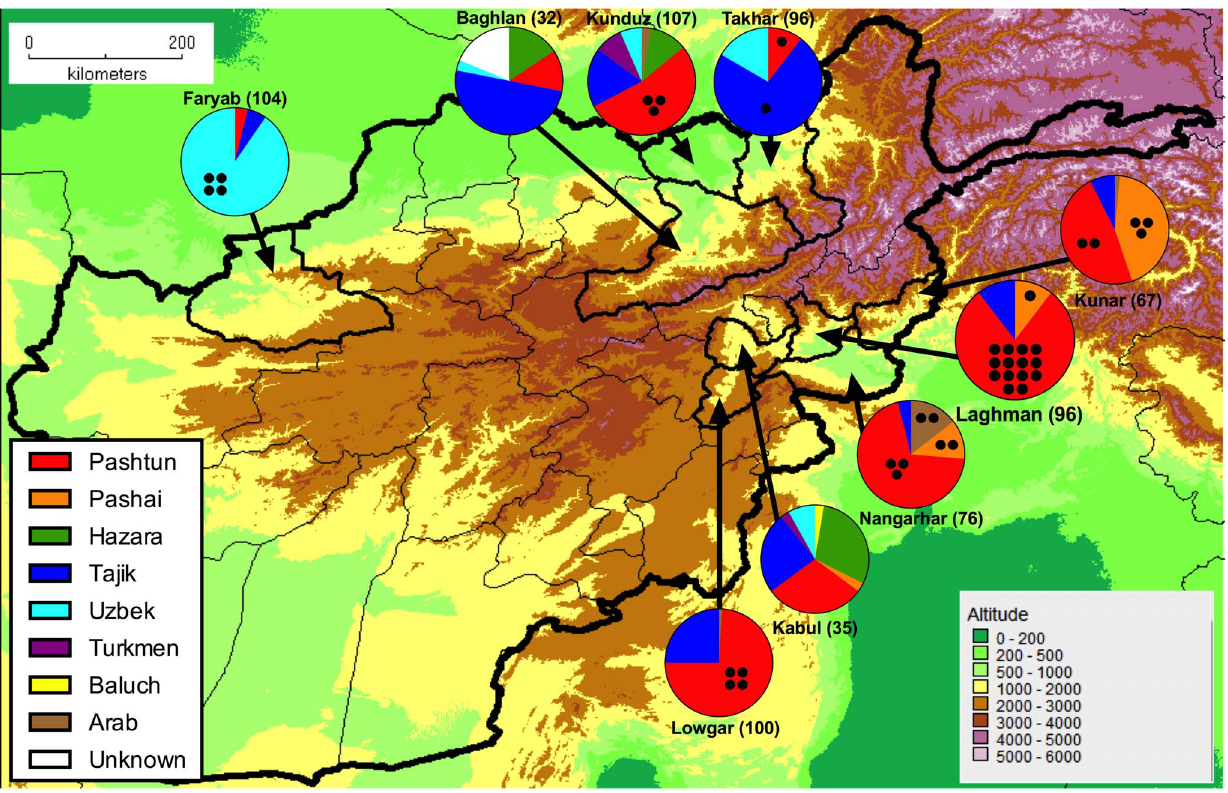
Figure 1. Location, ethnicity and number of Mediterranean variants for the individuals studied. Black circles placed within the relevant segment represent individuals of a particular ethnic group with the 563C . T Mediterranean mutation. The number of individuals sampled in each province is shown next to the province name.